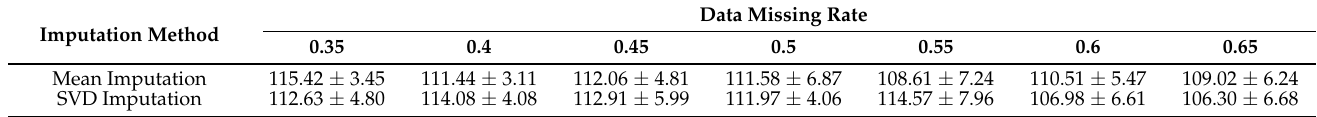
Table 2. The SMAPE score (mean and standard deviation) by using mean imputation and SVD